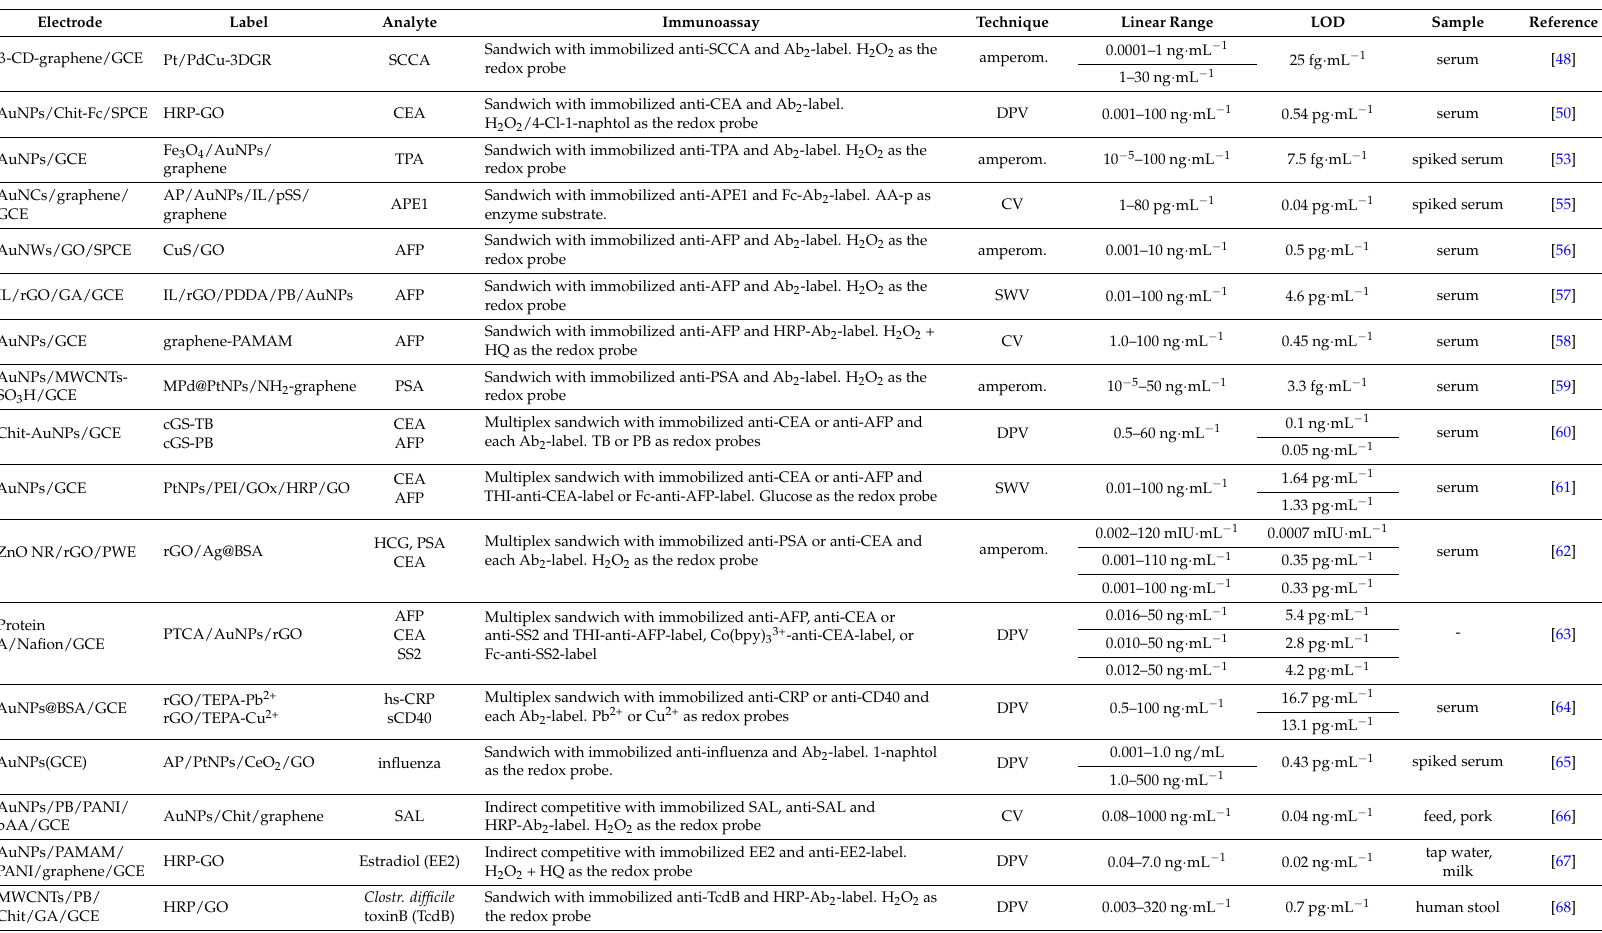
Table 2. Electrochemical immunosensors using graphene nanomaterials as